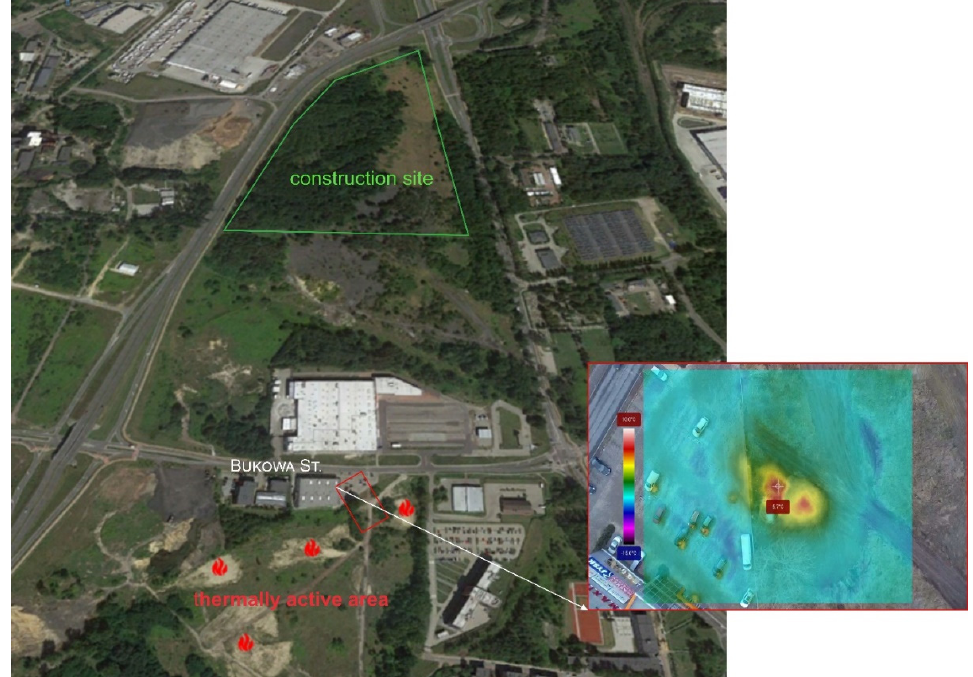
Figure 3. Location of the construction site and the neighbouring areas (own elaboration).